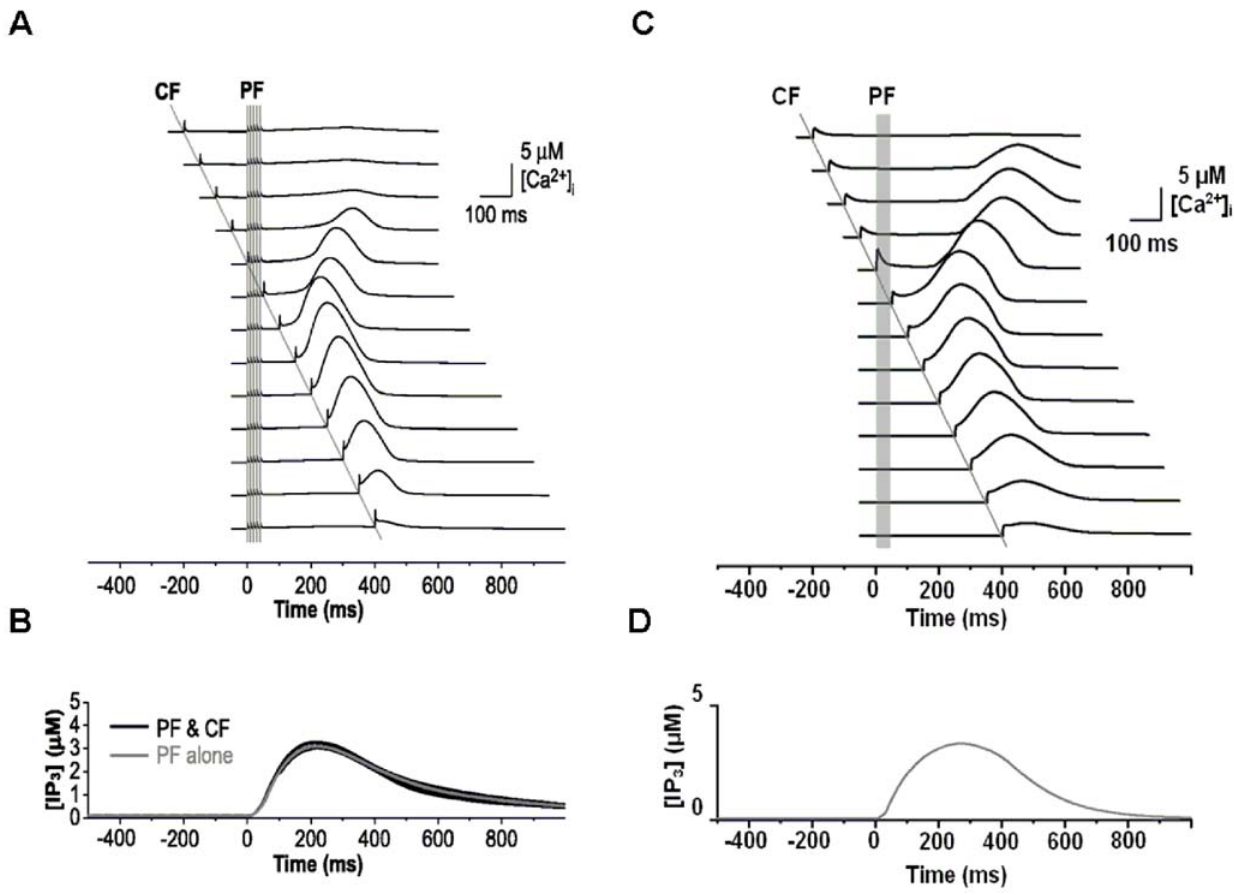
Figure 3. Slow activating regenerative Ca 2 + release dependence on the timing of PF-CF inputs. A. Simulation results by Doi et al. [39] on Ca 2 + activations at conjunctive PF-CF inputs with various intervals between the PF input and CF input. The PF input is delivered at 0 ms, indicated by the five vertical lines in panel A and a vertical gray bar in panel C. CF signal is given at 2 200 , + 400 ms, as indicated by the single diagonal line. B. IP3 time courses in response to the various PF-CF inputs. Note that the IP3 profiles are almost identical regardless of the timing of PF-CF inputs or even for PF input alone. C. Our new model generates profiles of calcium activation similar to the model in A. D. Simulation by our model of IP3 activation at PF input. The new model adopts the results in panel B and uses just one IP3 activation profile (similar to PF alone in panel B) in generating the various Ca 2 + profiles at various timing of PF-CF inputs in C. Panels A and B are from Doi et al. [39], with permission, copyright (2005) by the Society for